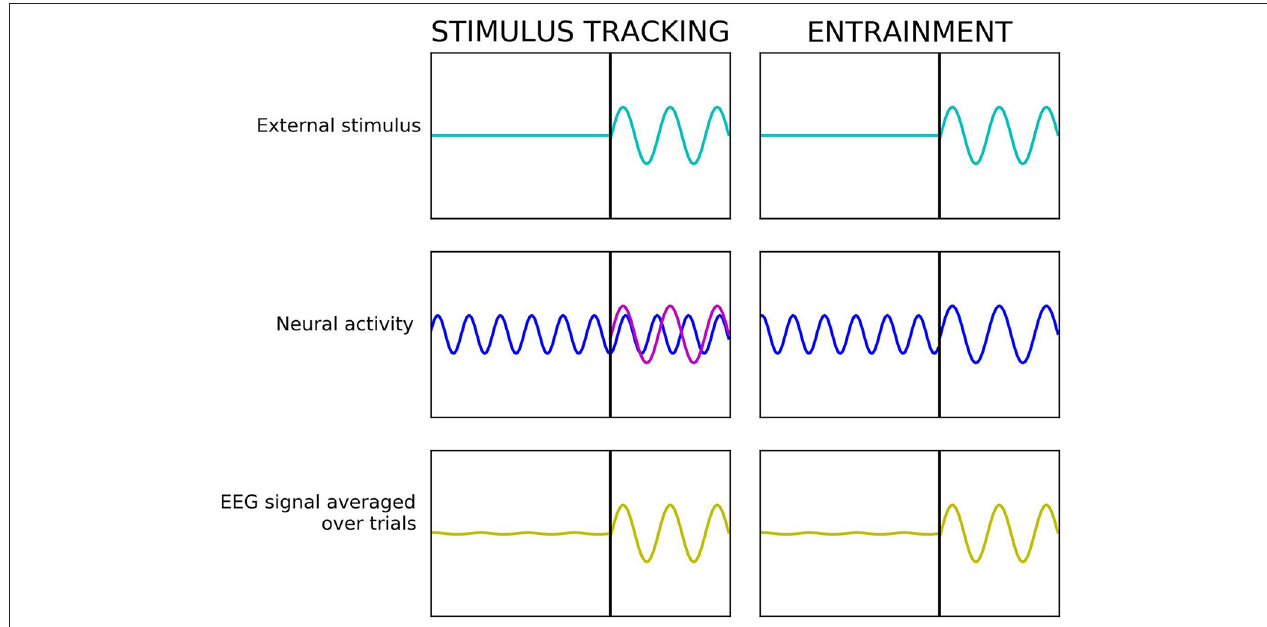
FIGURE 1 | Stimulus-tracking vs. entrainment—simplified example. In all the panels, the x -axis reflects the time and the y -axis—the amplitude of the signal. In stimulus-tracking (left), rhythmic external stimulation (light blue) causes a frequency-following neural sensory response (magenta), but the internal rhythms (dark blue) are not perturbated. In entrainment (right), rhythmic external stimulation (light blue) causes a resonant response at the frequency of the external stimulus by “hijacking” ongoing internal rhythms (dark blue). In both cases, the resulting electroencephalogram (EEG) signal (yellow) looks the